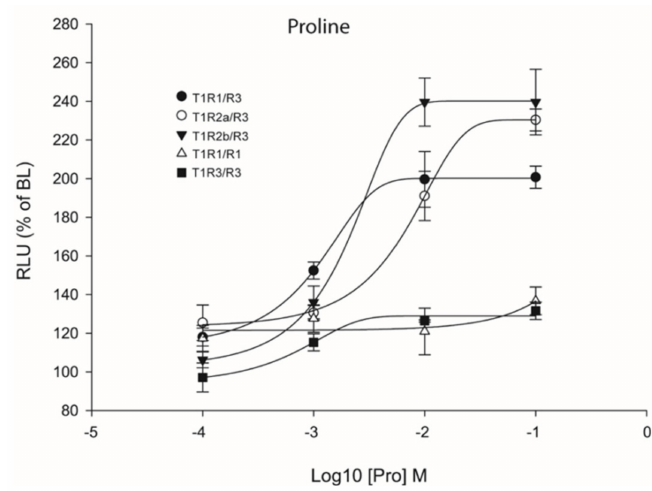
Figure 8. Comparisons of proline Log-dose response curves of activation in heterologous transfections of hetero- and homo-dimeric saT1R combinations of saT1R1 / R3 (black dots), saT1R2a / R3 (white dots), saT1R2b / 3 (black triangles), saT1R1 / R1 (white triangles) and saT1R3 / R3 (black squares). Response is measured as RLU mean ± SEM of four independent determinations normalized to the mean response of the same transfections stimulated with reduced assay medium (BME + 1% FBS), expressed as percentage relative to basal levels (BL).